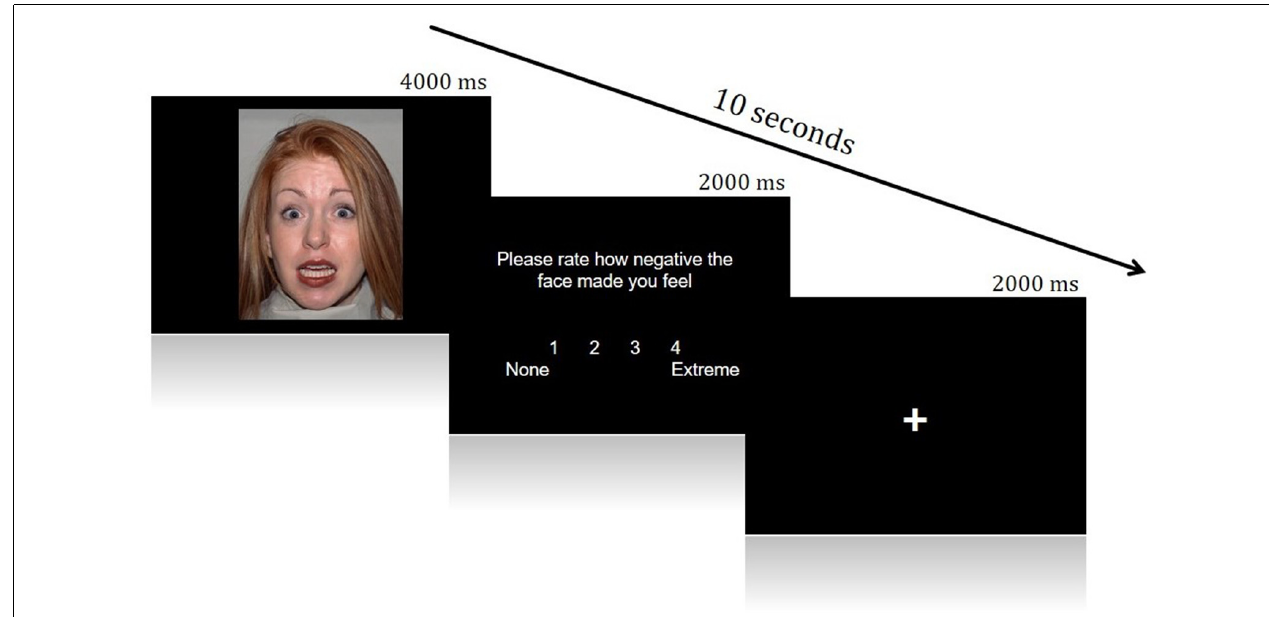
FIGURE 1 | Example of a single trial from the Face Processing